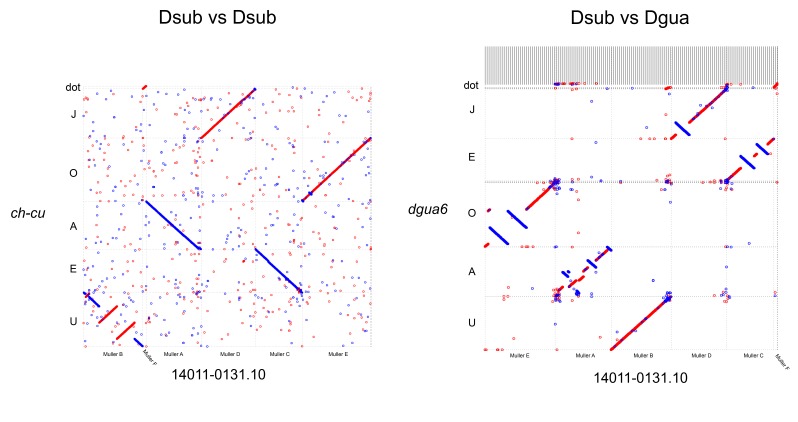
Whole genome alignments (MUMmer) of our Drosophila subobscura genome assembly (strain 14011–0131.10) with (A) D.subobscura strain ch-cu and (B) D. guanche.We show the Muller element naming scheme on the X axis and the subobscura group chromosome naming scheme on the Y axis.